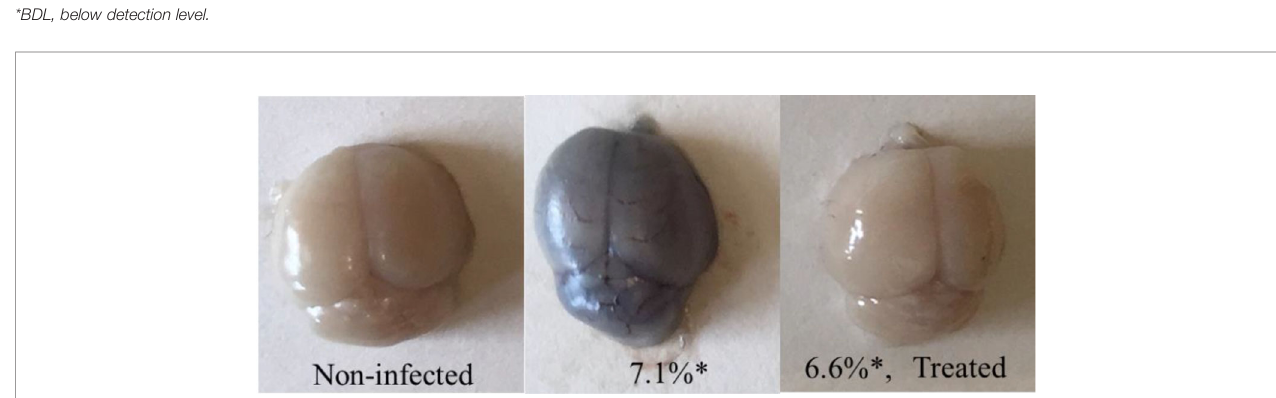
FIGURE 4 | The effect of treatment at three days post-infection on brain in fi ltration of Evans Blue. Brain examinations were conducted seven days post infection. *Parasitemias at the day of brain examinations. n = 3/group.